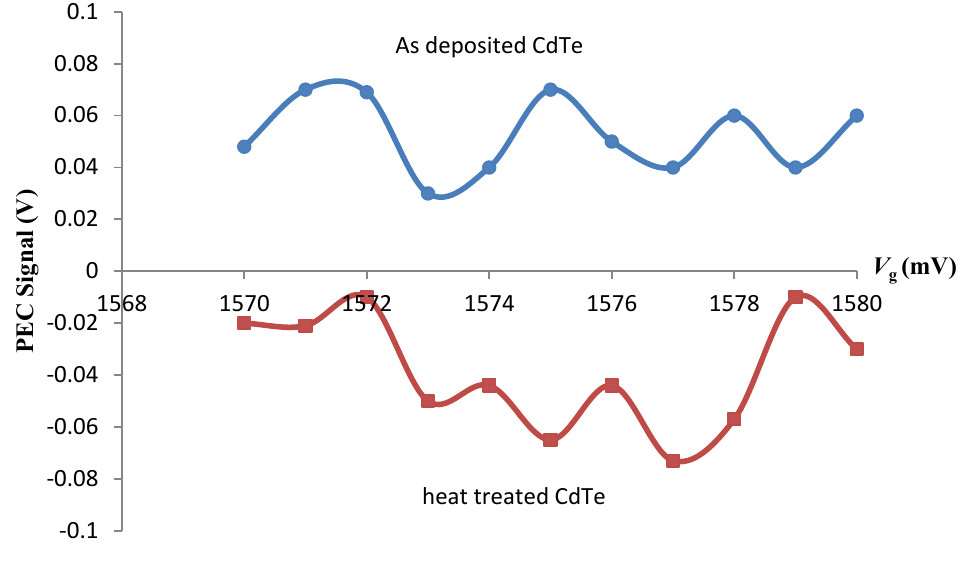
Figure 6. A set of electrodeposited p-type CdTe, and their type conversion to n-type after heat treatment in air, without CdCl 2